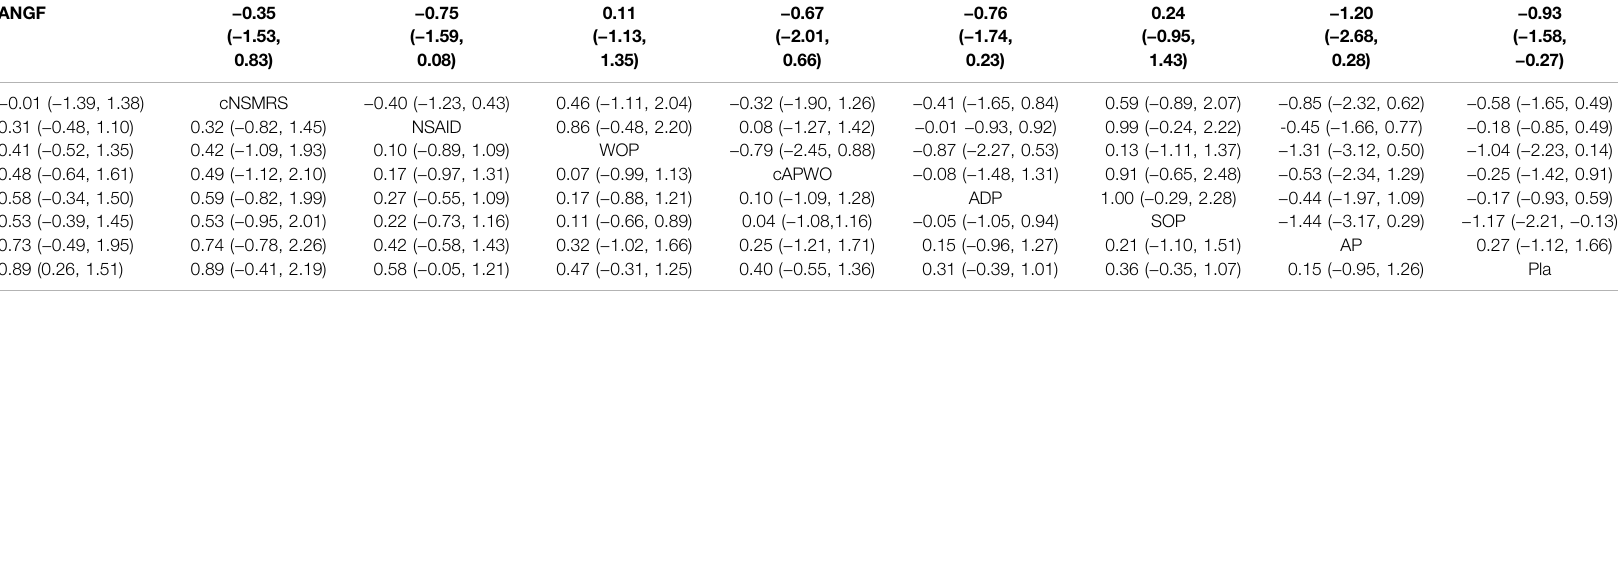
TABLE 2 | The league plots of main ef fi cacy analysis. Pain relief (Red) and function improvement (Blue). (From the top left to the bottom right, higher comparator vs lower comparator, SMD with 95% CI.) ANGF − 0.35